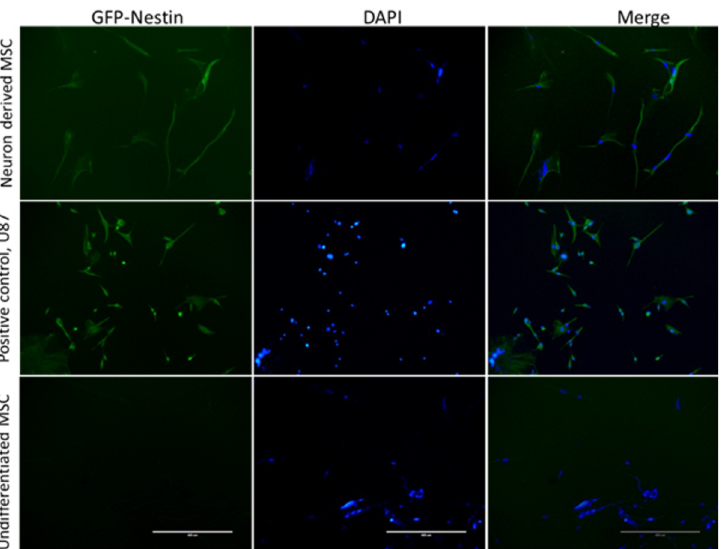
Fig 2. Nestin validation to confirm MSCs ability to differentiate into neurons. MSCs were differentiated into neurons through neuronal specific media. Top raw shows differentiated MSCs which are nestin, a neural positive marker (indicated by the green dye). Meddle raw shows positive control U87 (Neural cell line) which are also nestin positive, green dye. Bottom raw shows negative stain for nestin on undifferentiated MSCs (Indicated by the absence of color).